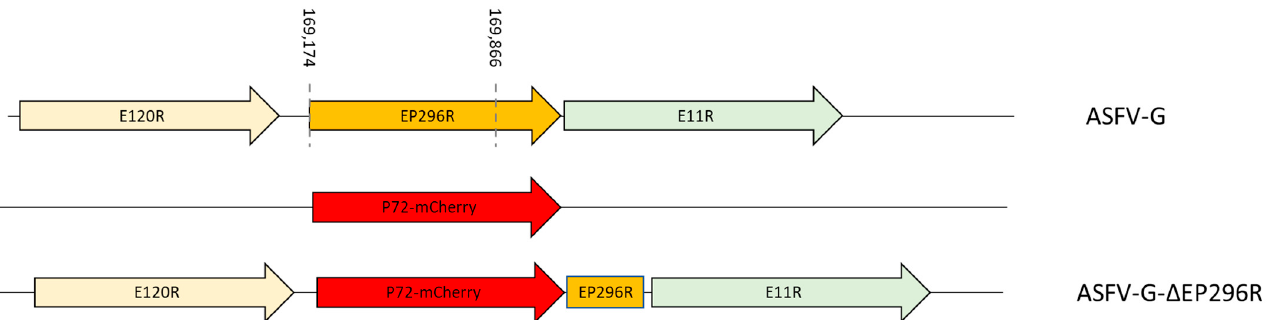
Figure 4. Development of ASFV-G- ∆ EP296R. The recombinant vector composed by the p72 promoter and a mCherry cassette and the gene positions are indicated. The homologous arms were designed to have flanking ends to both sides of the deletion/insertion cassette. The nucleotide positions of the deleted area are shown by the dashed lines. The resulting ASFV-G- ∆ EP296R virus is shown on the bottom.